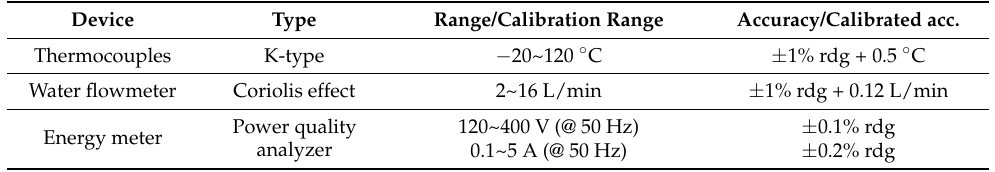
Table 1. Measurement